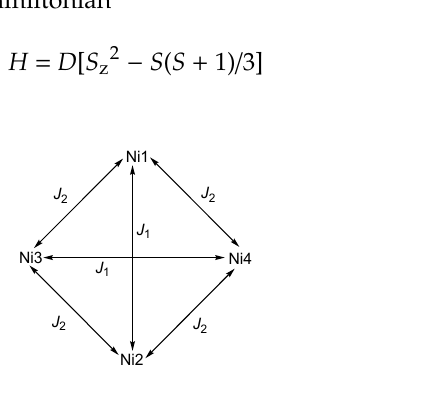
Scheme 1. Coupling scheme for 2 ; for 1 , the cluster lies on a two-fold rotation axis and thus Ni2 is equivalent to Ni1 and labeled Ni1’; correspondingly, Ni3 and Ni4 are equivalent and labeled as Ni2, with Ni2’ in the structural data, see Figure 3b.